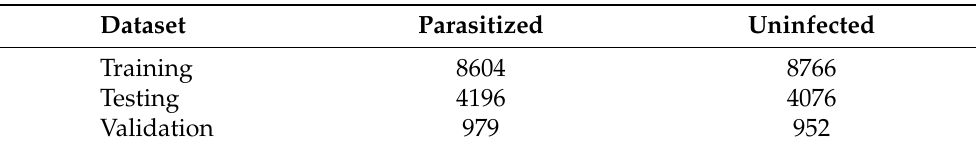
Table 2. Partitioning of the test dataset into training, testing, and validation datasets before perform- ing data